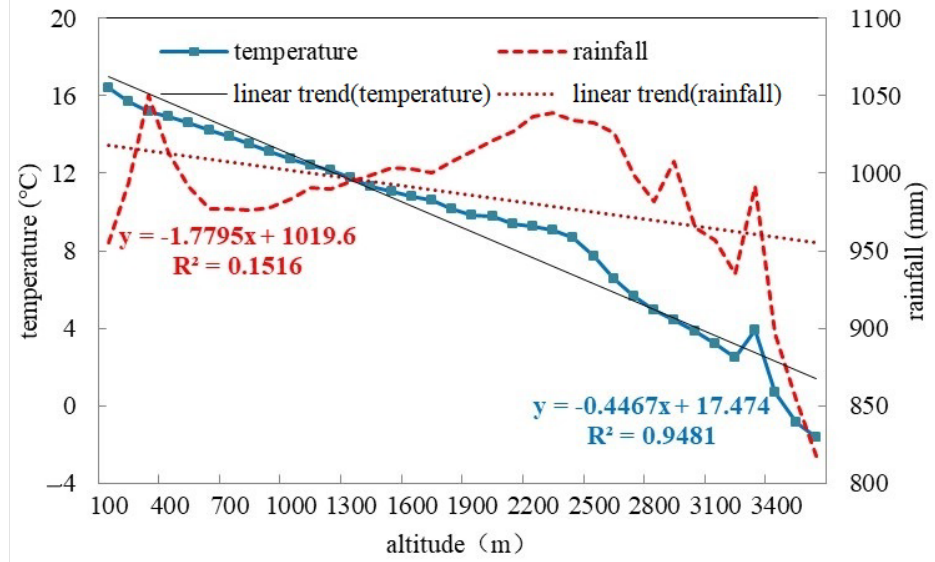
Figure 9. The AMT (unit: °C) and AMRA (unit: mm) change with elevation in the QMs. The brown dashed line denotes the AMRA curve, and the blue dashed line denotes the AMT curve. The black line denotes the linear trend of the temperature curve, and the black dashed line denotes the linear trend of the rainfall curve.